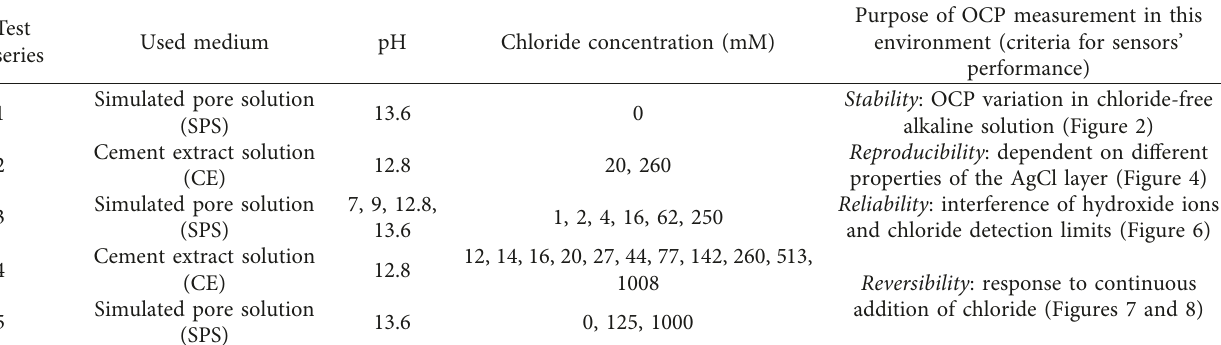
Table 2: Model solutions and criteria for sensors’